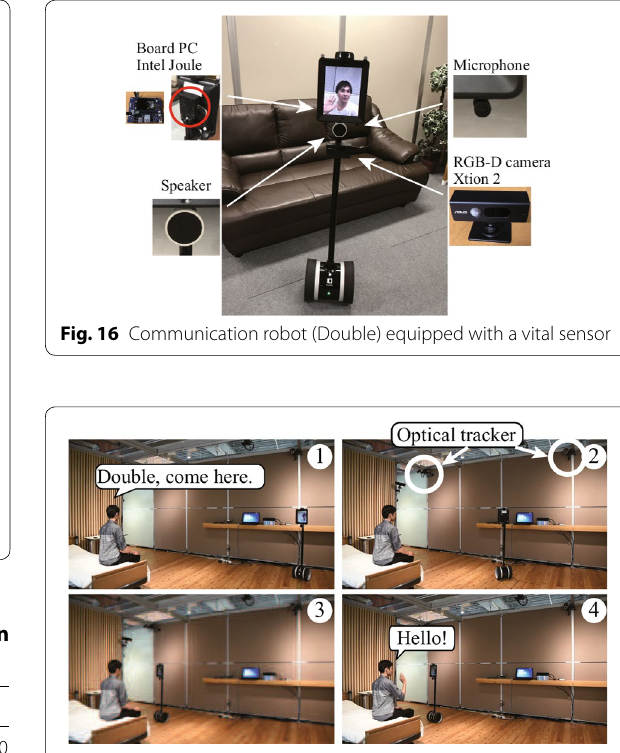
Fig. 17 Communication robot (Double) approaches to user